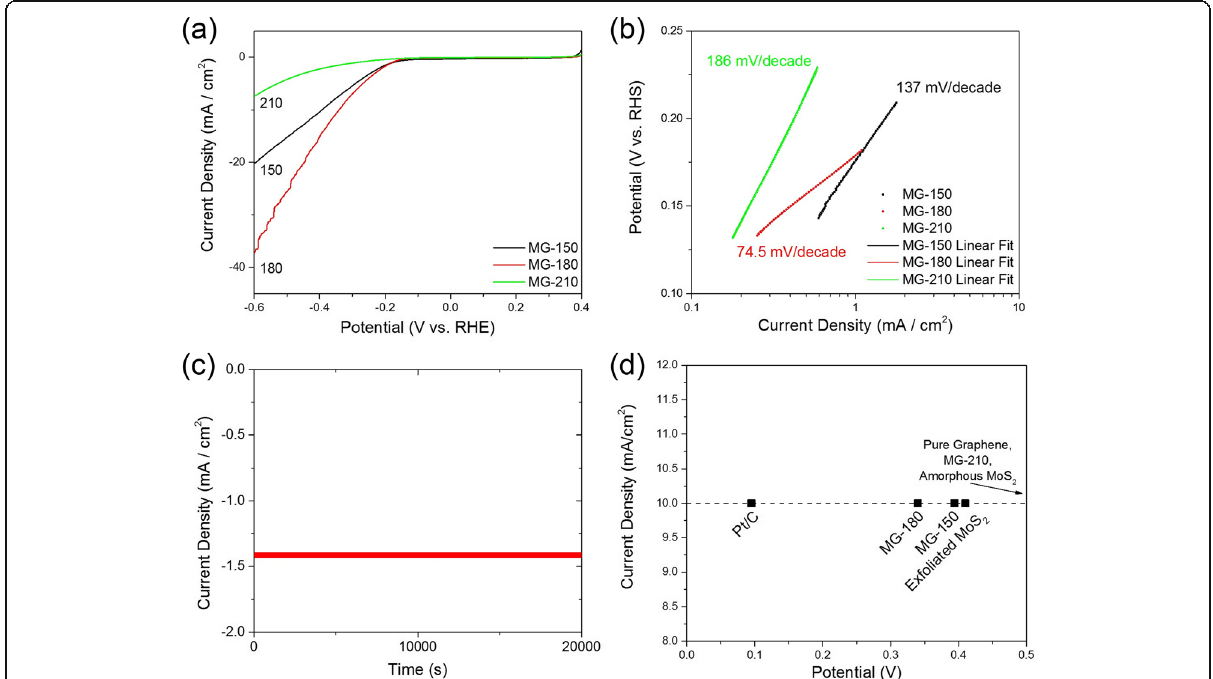
Fig. 5 HER performance comparison. a Polarization curves after IR correction. b Corresponding Tafel plots of MoS 2 /graphene hybrids prepared at 150, 180, and 210 °C, c I-t scan of MG-180 for 20,000 s. d Comparison of overpotentials at 10 mA/cm 2 for MG-150, MG-180, and MG-210 with Pt/C, exfoliated MoS 2 , and amorphous MoS